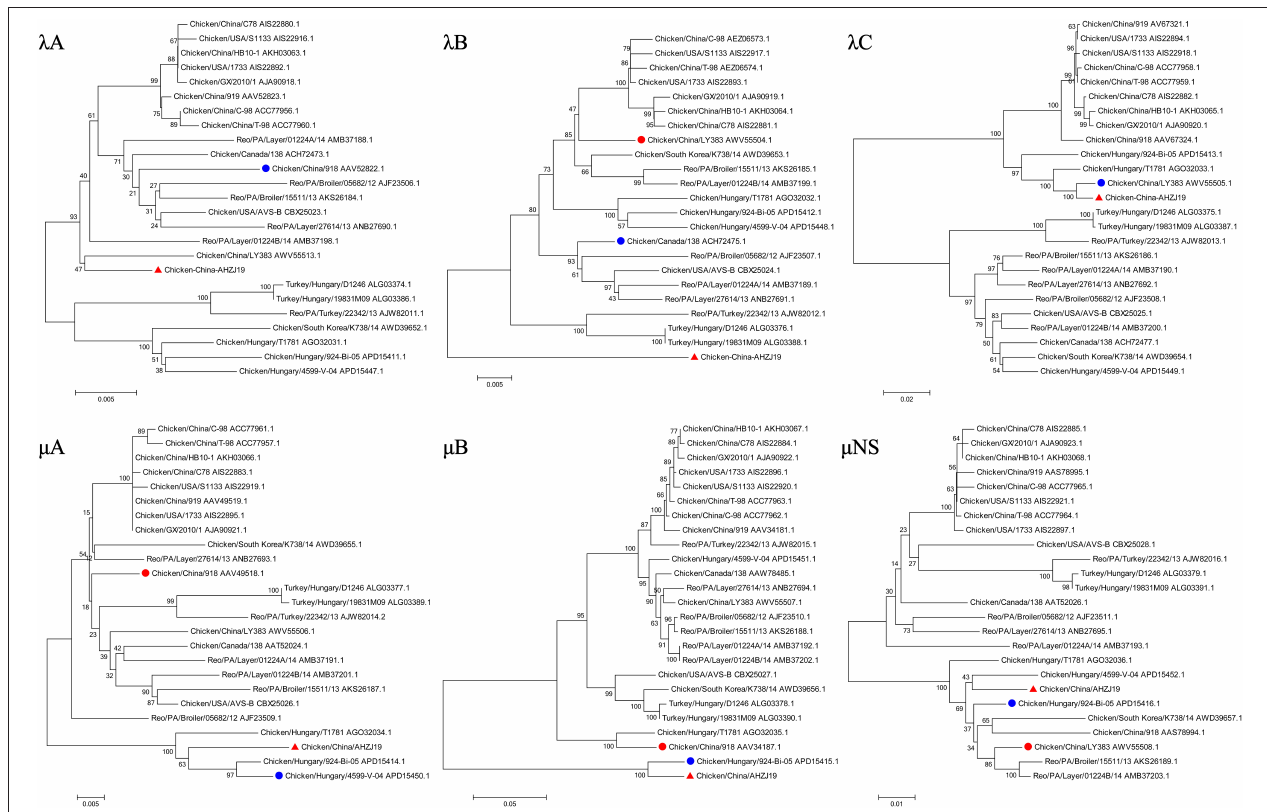
FIGURE 3 | Phylogenetic trees of AHZJ19 and reference strains based on aa sequences of λ A, λ B, λ C, µ A, µ B, and µ NS proteins. The phylogenetic tree was constructed using the neighbor-joining method (1,000 bootstraps) with MEGA6. The AHZJ19 strain isolated in Anhui in 2019 is indicated by the red triangle. The strain sharing the highest homology with AHZJ19 in the world and in China is indicated by the blue and red circle,